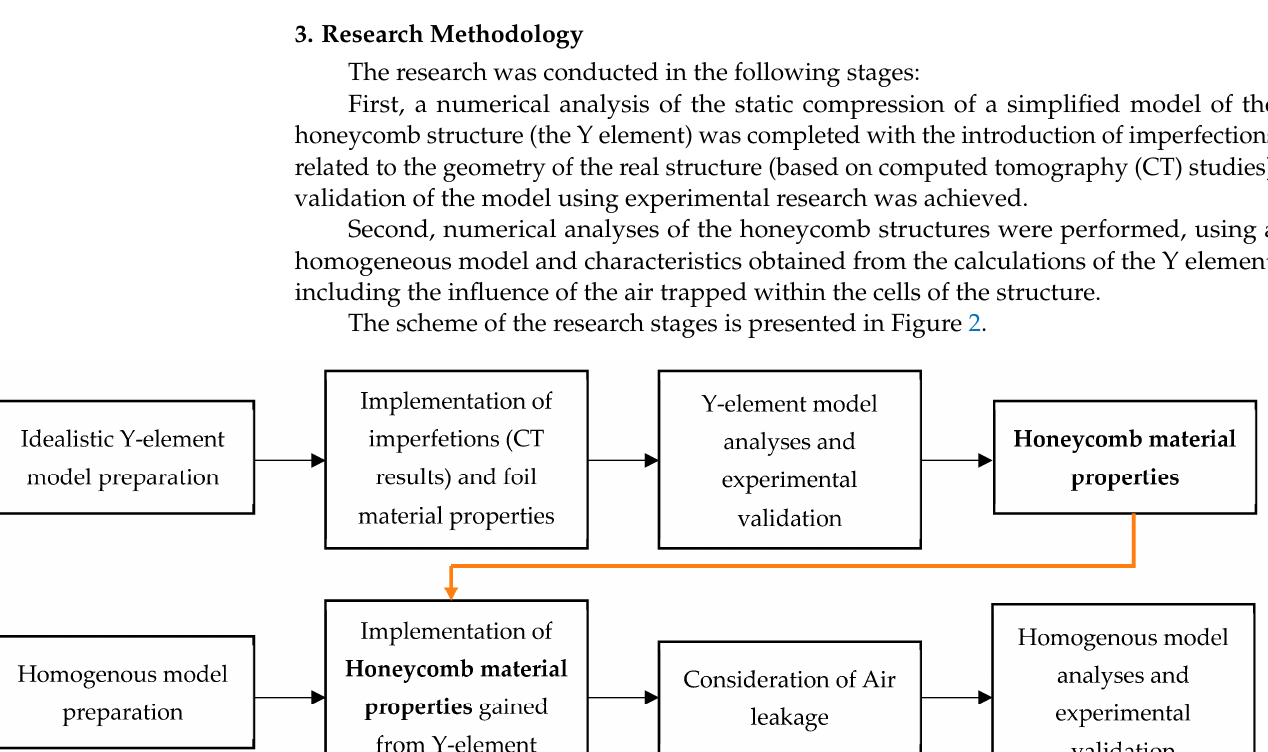
Figure 1. An example of the analyzed honeycomb structure ( left ), and the basic designations of the honeycomb’s structural elements ( right ) [9].